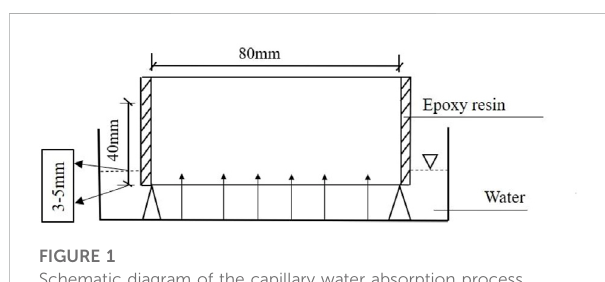
Schematic diagram of the capillary water absorption